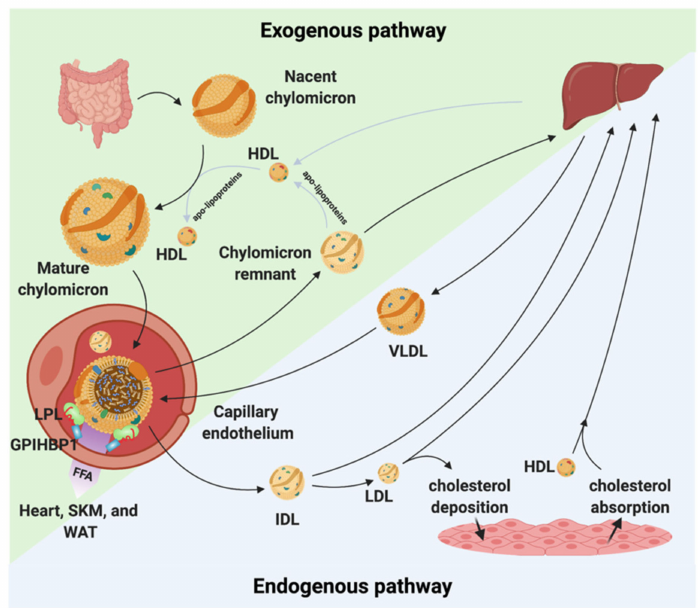
Figure 1. Chylomicron and VLDL life cycle. Chylomicrons are secreted from the intestines to the circulation where they extract apolipoproteins from HDL. The mature chylomicrons are arrested at the capillary endothelium by LPL that is in complex with glycosylphosphatidylinositol anchored high density lipoprotein binding protein 1 (GPIHBP1). LPL performs lipolysis on the encapsulated TGs, which releases free fatty acids that are taken up by the underlying tissues (white adipose tissue (WAT), skeletal muscle (SKM), and the heart). Upon complete hydrolysis, a chylomicron remnant particle is released to the circulation. The chylomicron remnant particle back-exchanges apolipoproteins to circulating HDL, before final catabolism in the liver. A similar life cycle is found for VLDL. VLDL is secreted from the liver and is arrested and hydrolyzed by the LPL • GPIHBP1 complex. This releases IDL, which can either be taken up by the liver or be hydrolyzed further into LDL. LDL deposits cholesterol esters in various tissues. HDL absorbs cholesterol and transports it to the